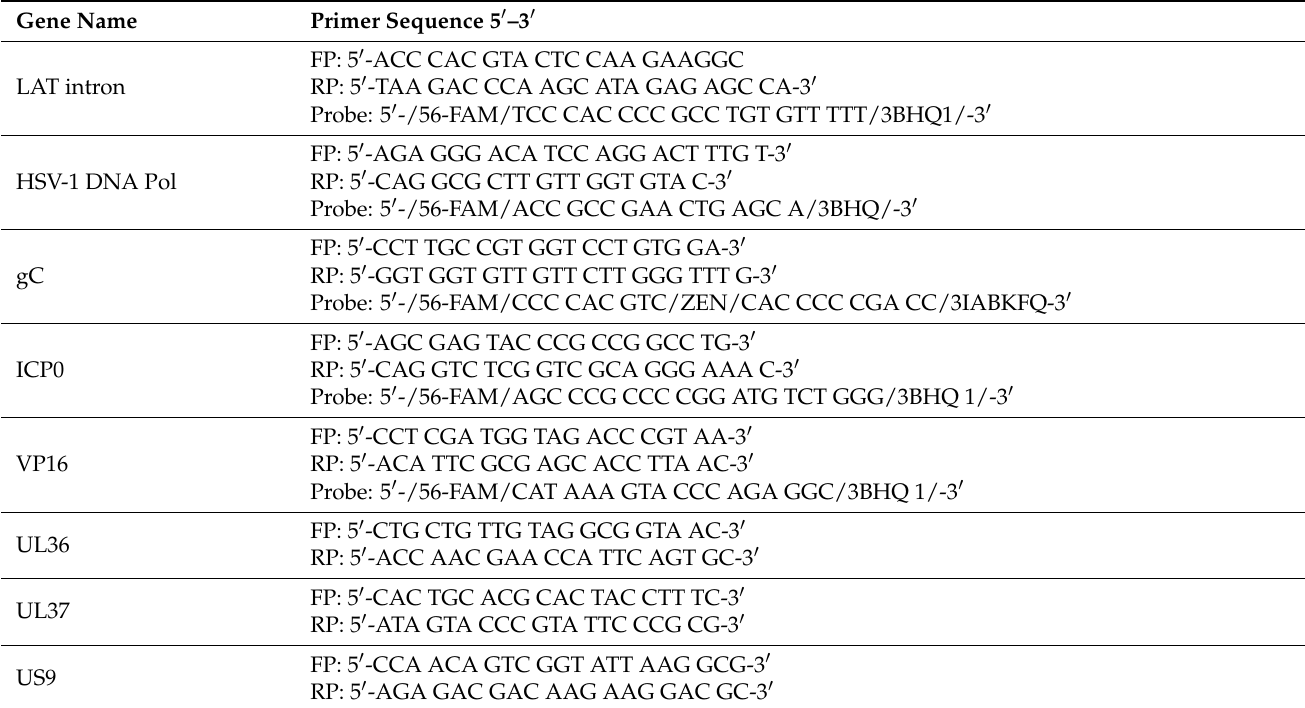
Table 1. List of primer